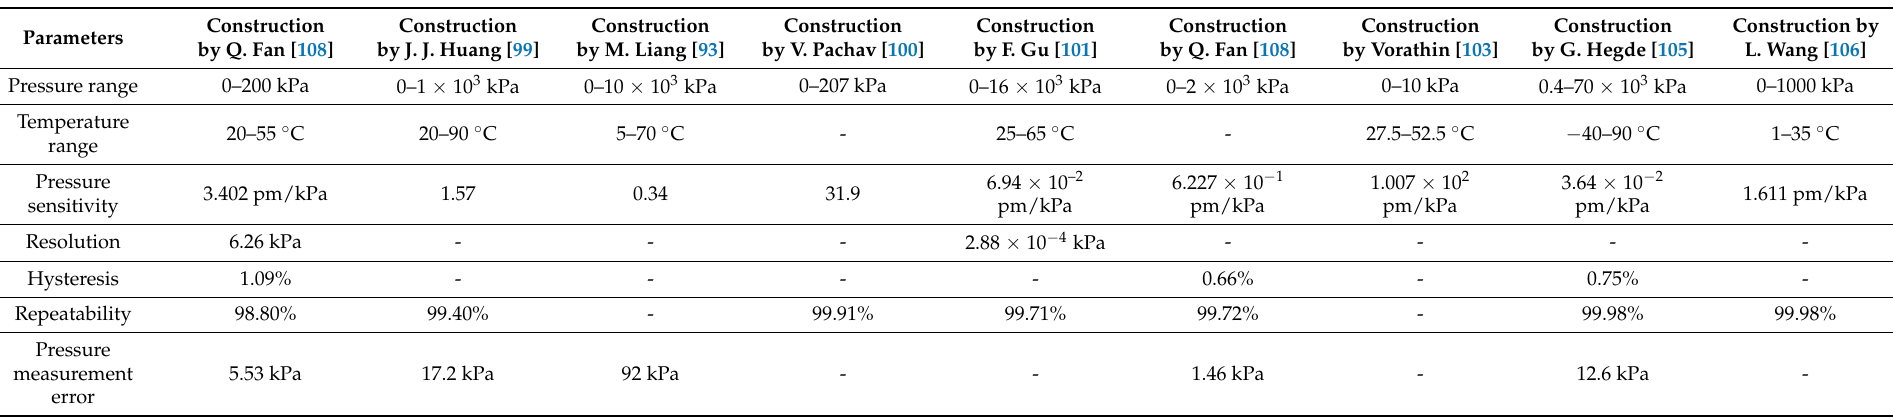
Table 6. Comparison of selected sensors with Bragg gratings